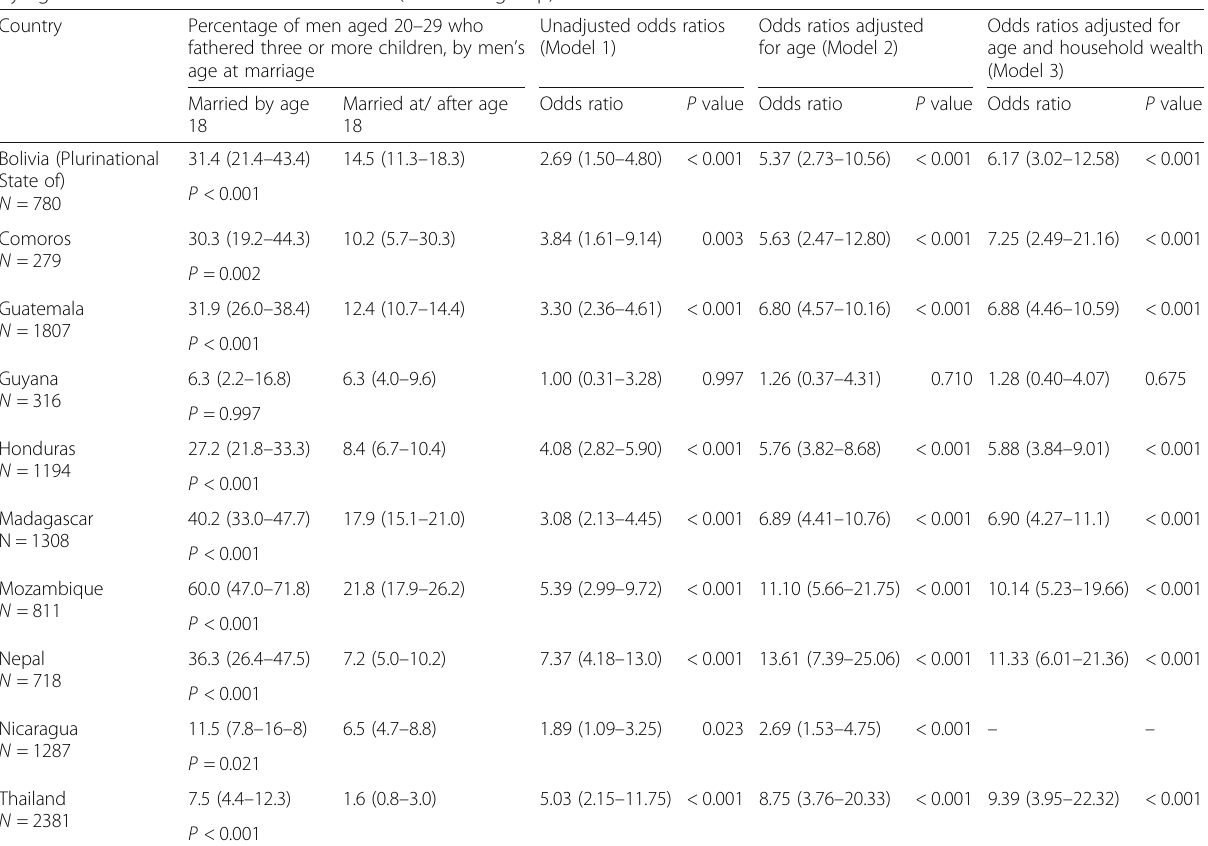
Table 5 The odds of having fathered three or more children at the time of survey, comparing men aged 20 – 29 who were married by age 18 with those married at or after 18 (reference